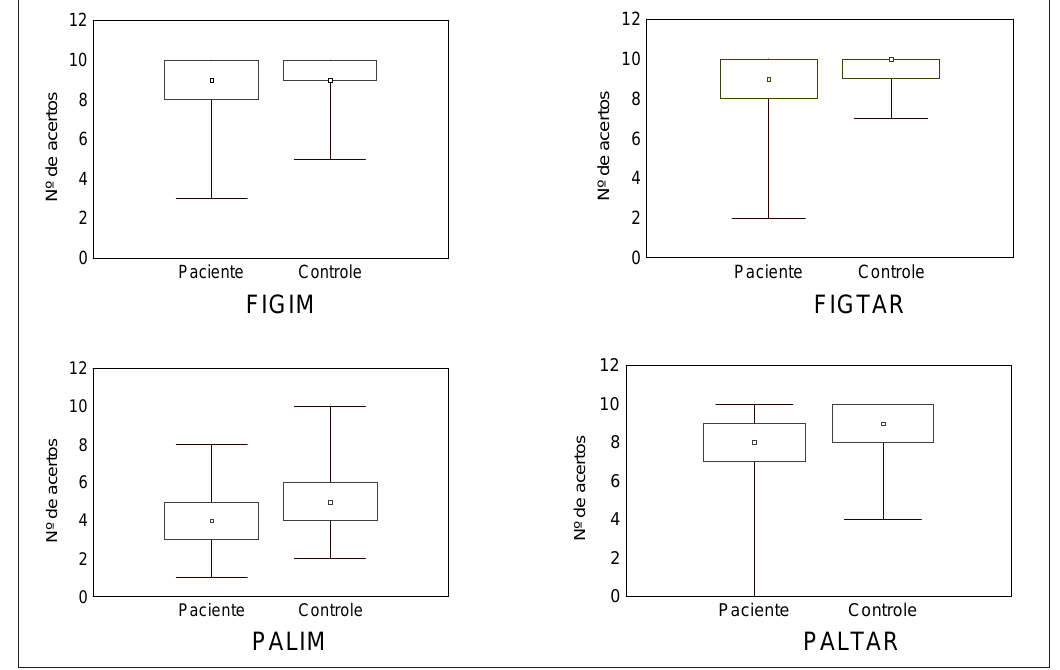
Figura 1 . Número de acertos (mediana, quartis, mínimo-máximo) nos testes de memória obtidos pelos indivíduos controle e